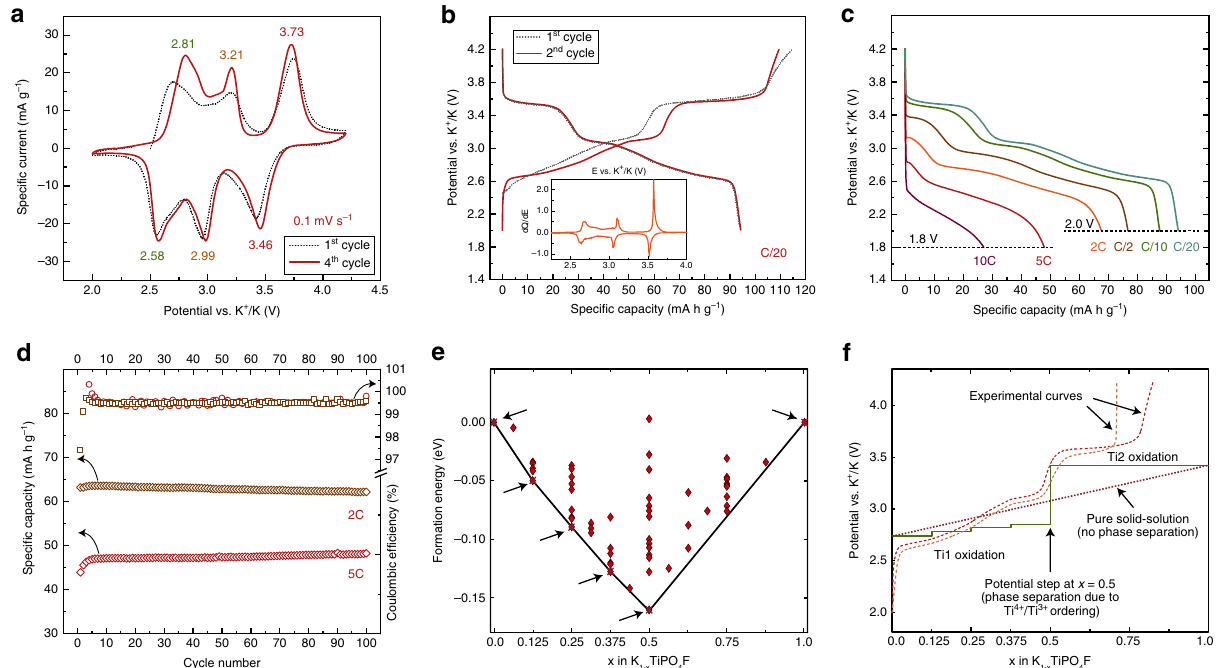
Fig. 2 Electrochemical and computational characterization of KTiPO 4 F. a CVs at 100 µ V s – 1 scan rate in the 2.0 – 4.2 V vs. K + /K range. b First and second charge-discharge cycles at a C/20 rate. Inset: dQ/dE differential plot for the second galvanostatic cycle at C/20. c Galvanostatic discharge curves at rate capabilities measurements, 1C is equal to 133 mA g − 1 (C/2 charge rate was applied in all cycles starting from C/2). d Discharge capacities during extended cycling at 2C and 5C charge/discharge rate for 100 cycles and coulombic ef fi ciency. e Formation energies calculated using DFT + U method in the K 1- x TiPO 4 F system coupled with the clusters expansion method to predict possible ground state structures at intermediate concentrations. Crosses and arrows mark stable phases. f Theoretical voltage pro fi le based on the ground state phases obtained from the convex hull (solid line), experimental charge curve (dashed line) and “ gedanken ” pure solid-solution voltage pro fi le with no phase separation or charge ordering (dotted